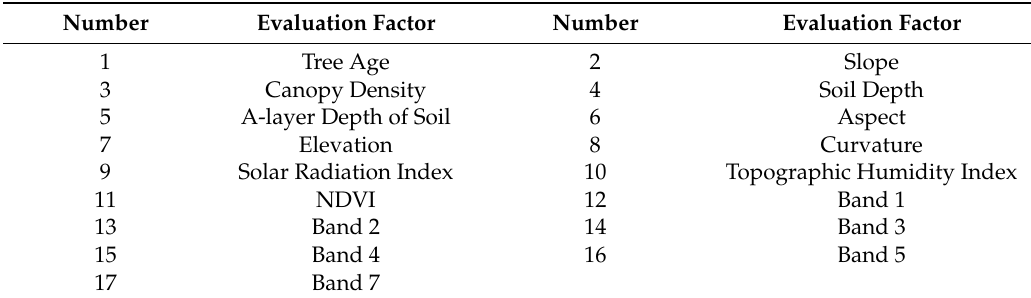
Table 1. Comprehensive evaluation factors for forest